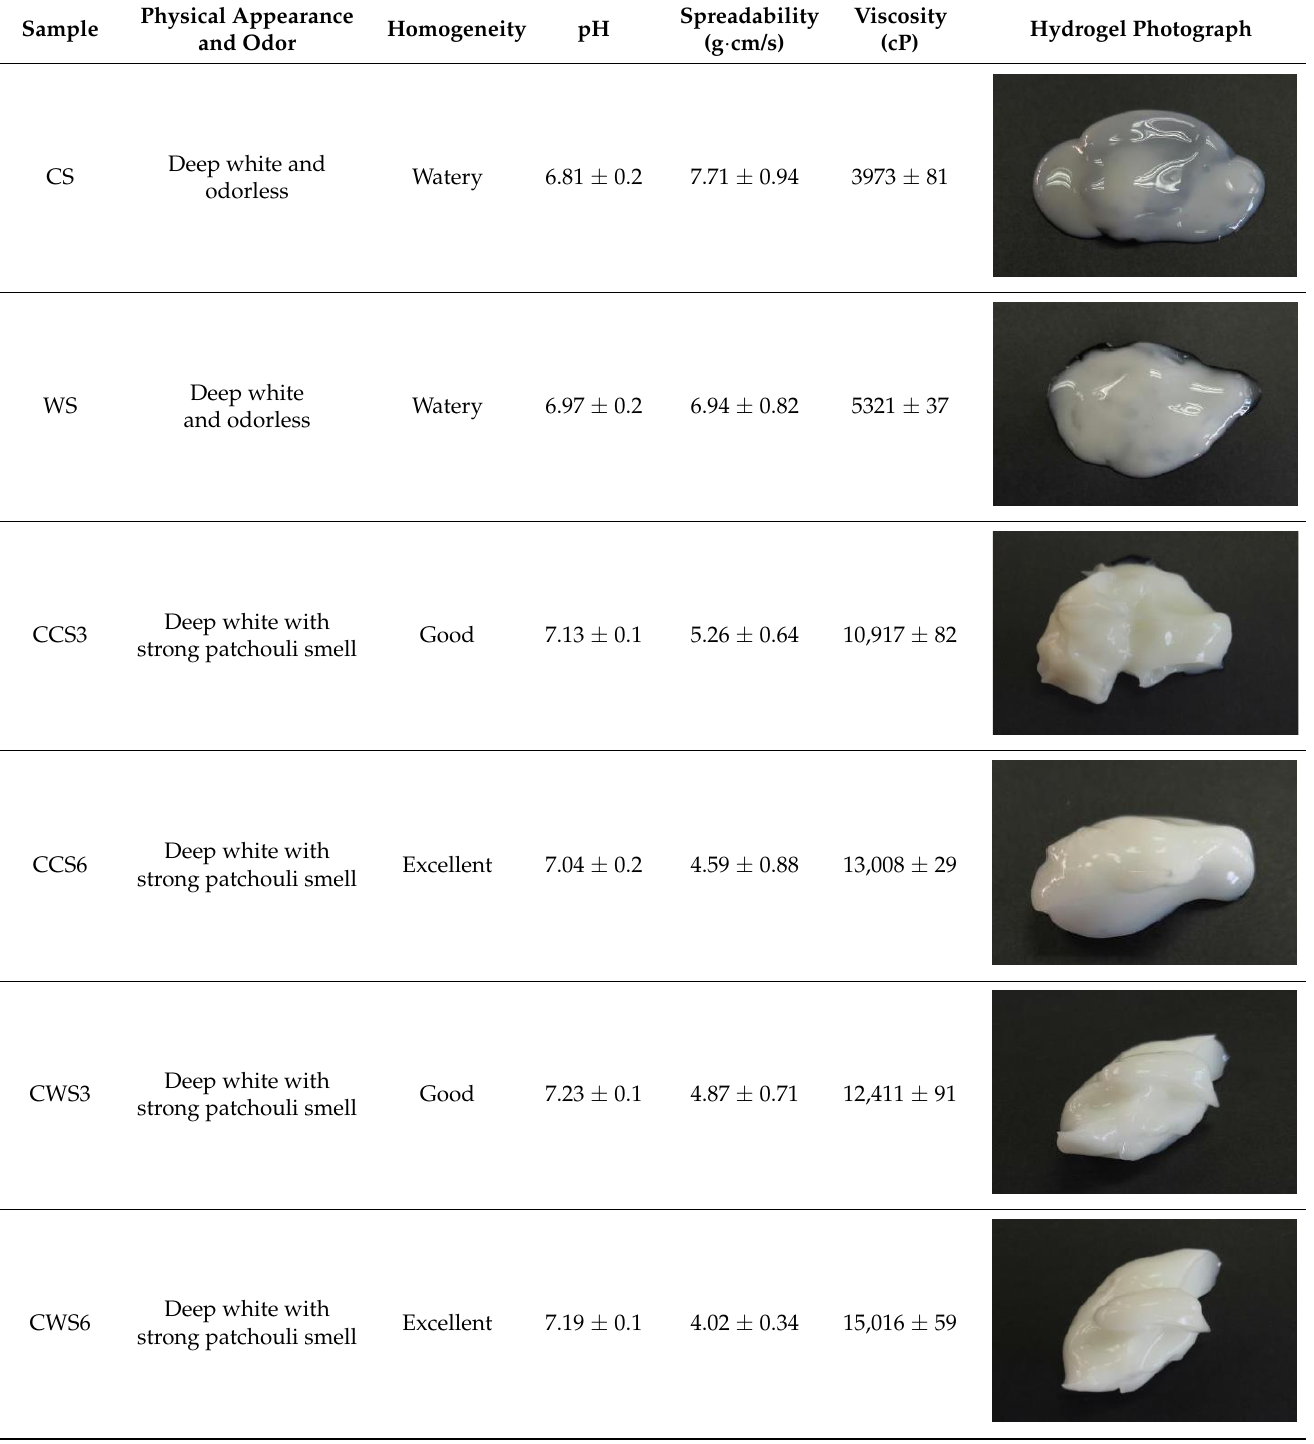
Table 1. Physical appearance and properties of prepared hydrogel samples.